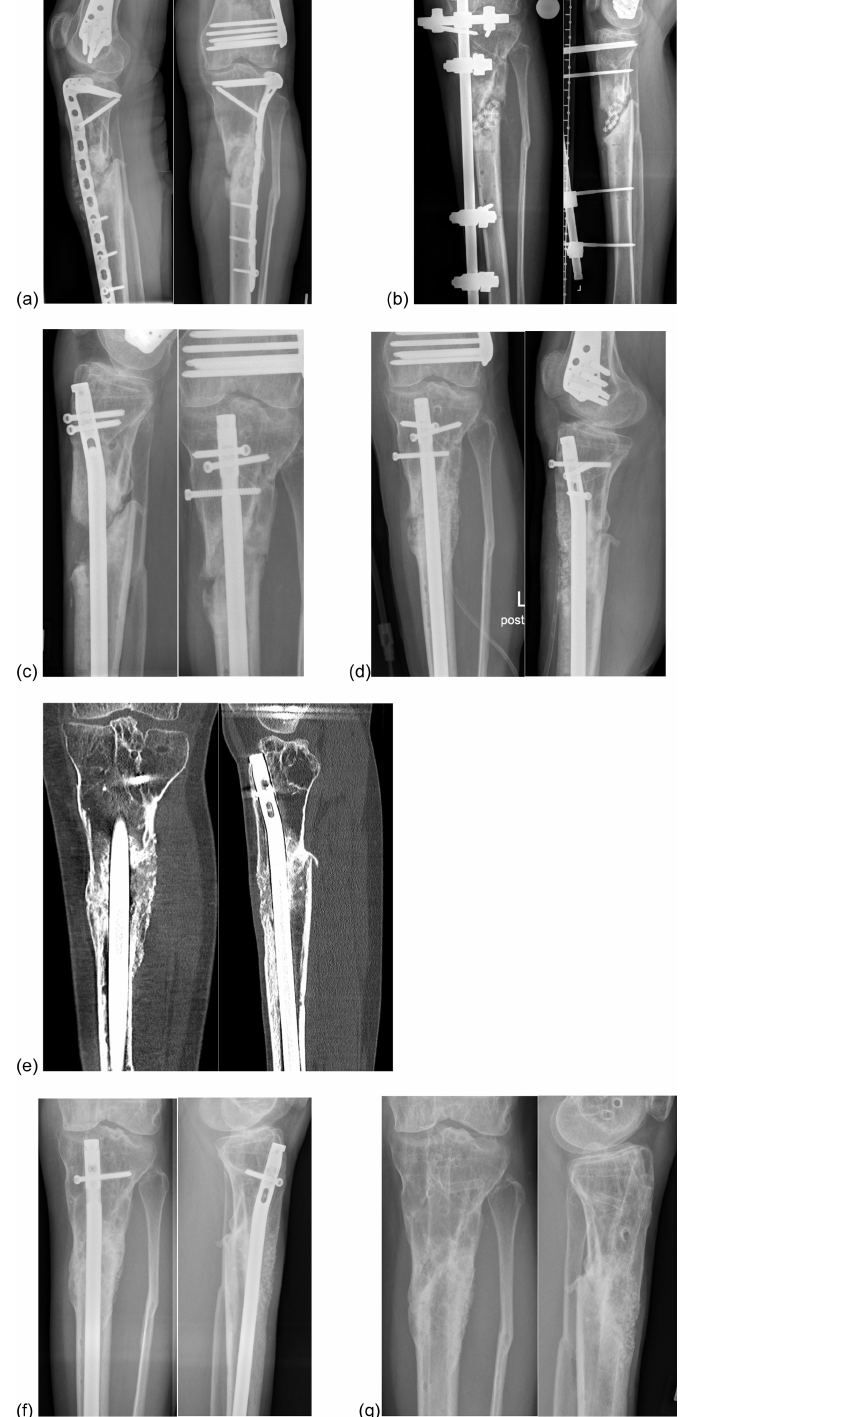
Figure 3. Bioactive glass in combination with autologous bone graft in a patient with an infected non-union of the proximal tibia. (a) Infected non-union of the proximal tibia and plate osteosynthesis. (b) After debridement with removal of the internal osteosynthesis, resection of the infected bone and implantation of a PMMA chain. (c) Re-osteosynthesis with an intramedullary nail after control of infection. (d) Defect filling with a combination of bioactive glass S53P4 and autologous bone graft. (e) Twelve months after defect filling. (f) Two years after defect filling: bony fusion. (g) Final result. Abbreviations: AB: autologous bone graft; BAG: bioactive glass; PMMA: polymethylmethacrylate; VEGF: vascular endothelial growth